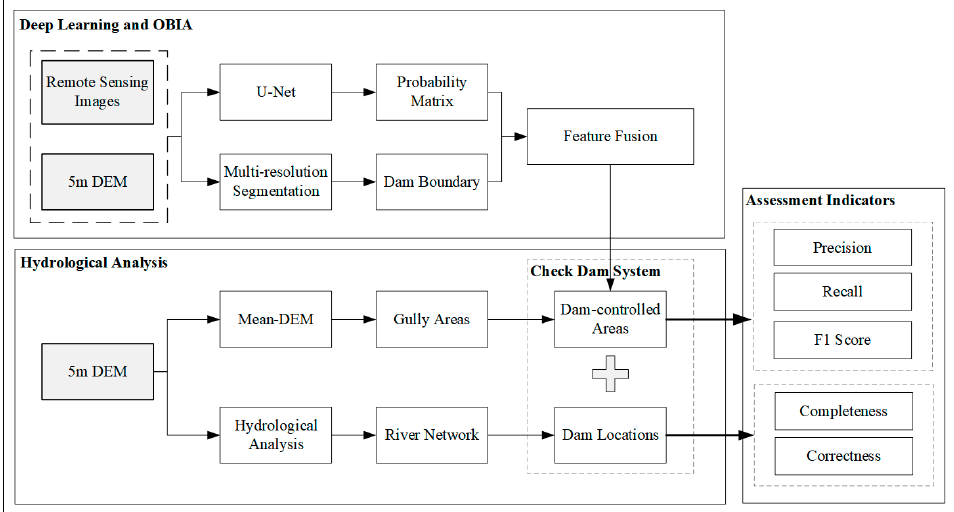
Figure 3. Workflow of the proposed method.